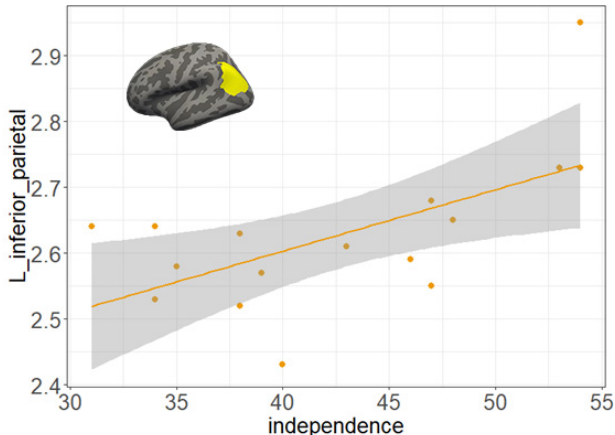
Figure 3. Scatter plots indicating the significant correlations between the independence scores of the volitional qualities and cortical thickness of the left inferior parietal lobule.